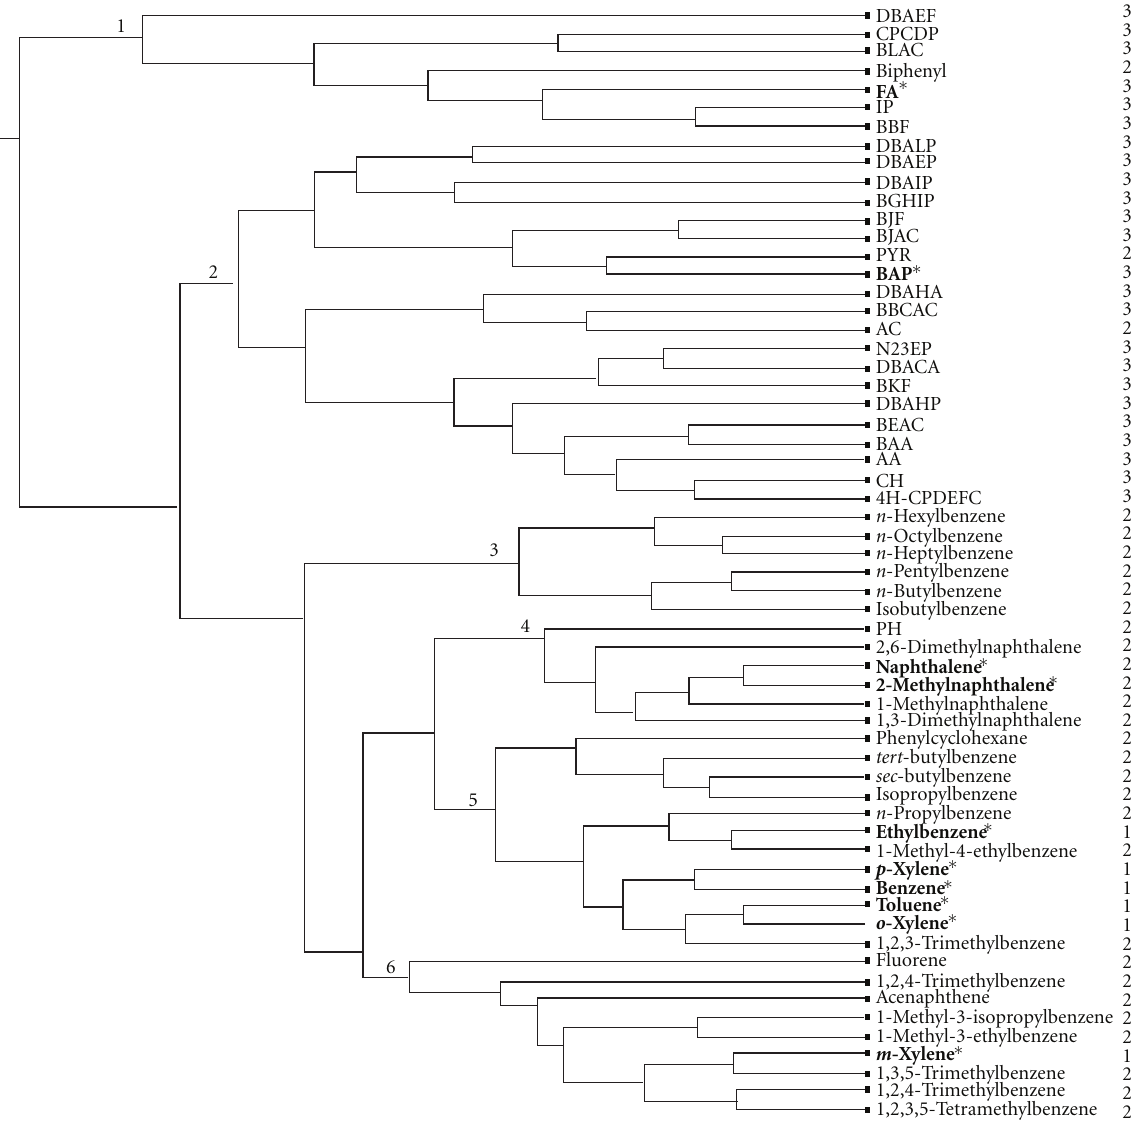
Figure 3: Hierarchical cluster analysis based on CoMFA for all aromatic fractions. Proposed surrogate or component chemicals are shown in bold and with asterisks. DBalP: Dibenzo[a,l]pyrene, BlAC: Benzo[l]aceanthrylene, IP: Indeno[1,2,3-c,d]pyrene,